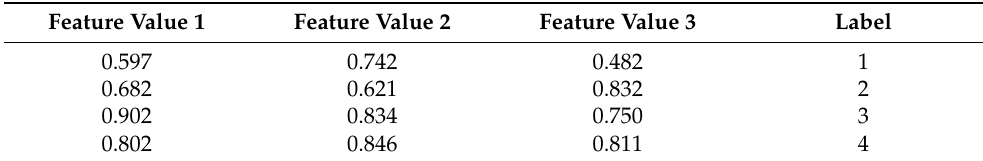
Figure 9. The MPE of imf3. Table 8. The feature vectors and labels.